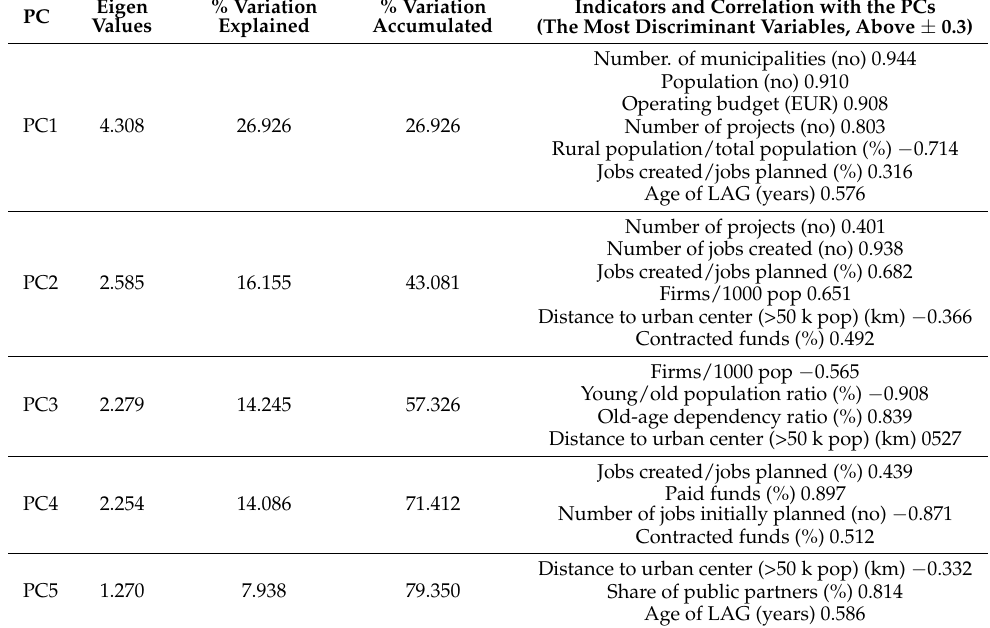
Table 2. Results of the principal component